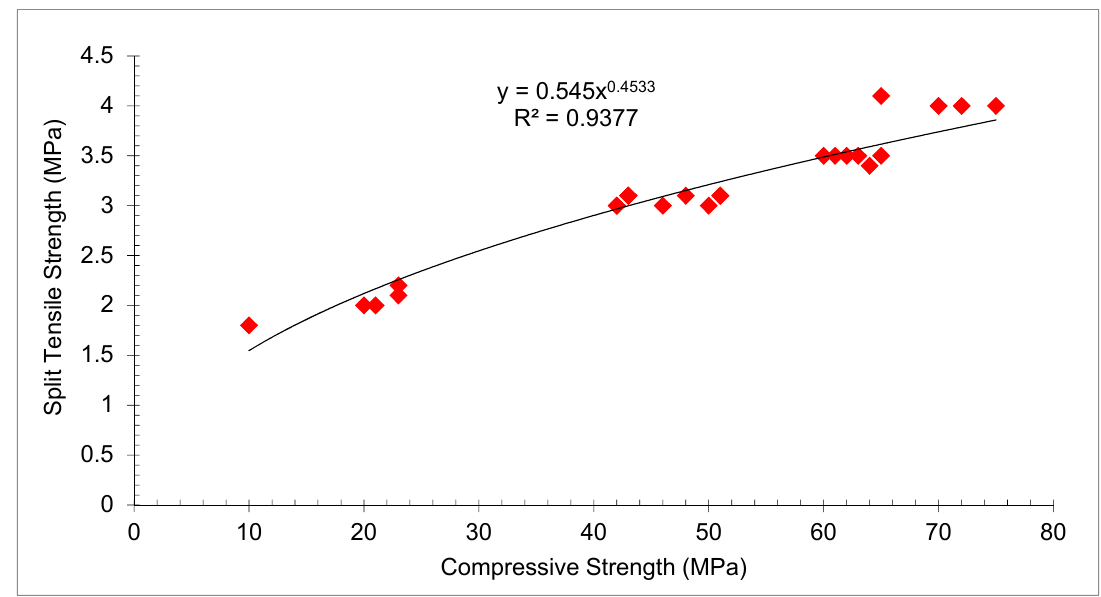
Figure 11. The correlation between compressive and tensile strength: data source [65] .